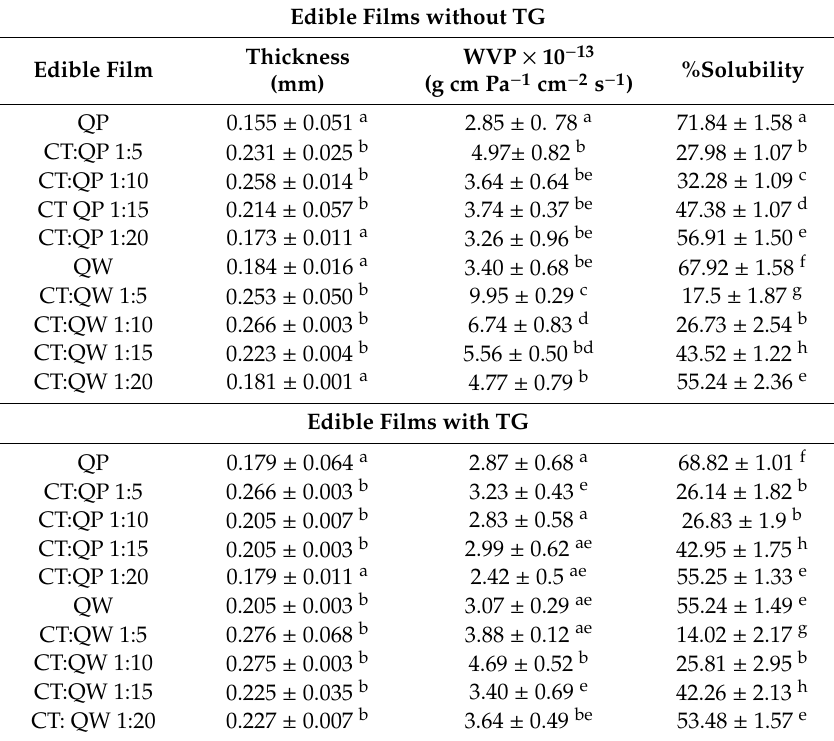
Table 3. Physical properties of chitosan and quinoa protein (Pasankalla and Willd). Edible Films without